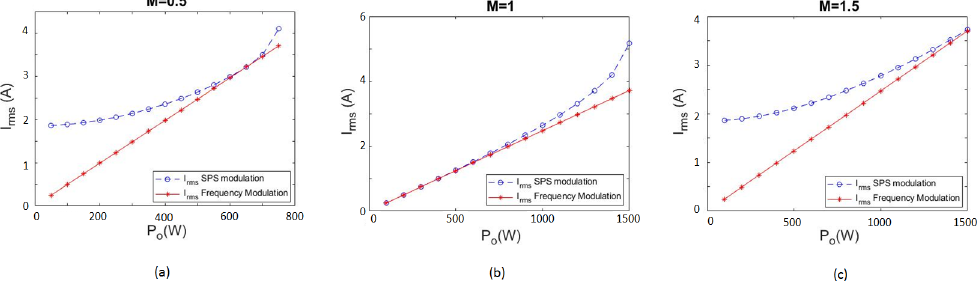
Figure 16. Comparison of the RMS tank currents between the SPS modulation and frequency modulation schemes for ( a ) M = 0.5, ( b ) M = 1, and ( c ) M =